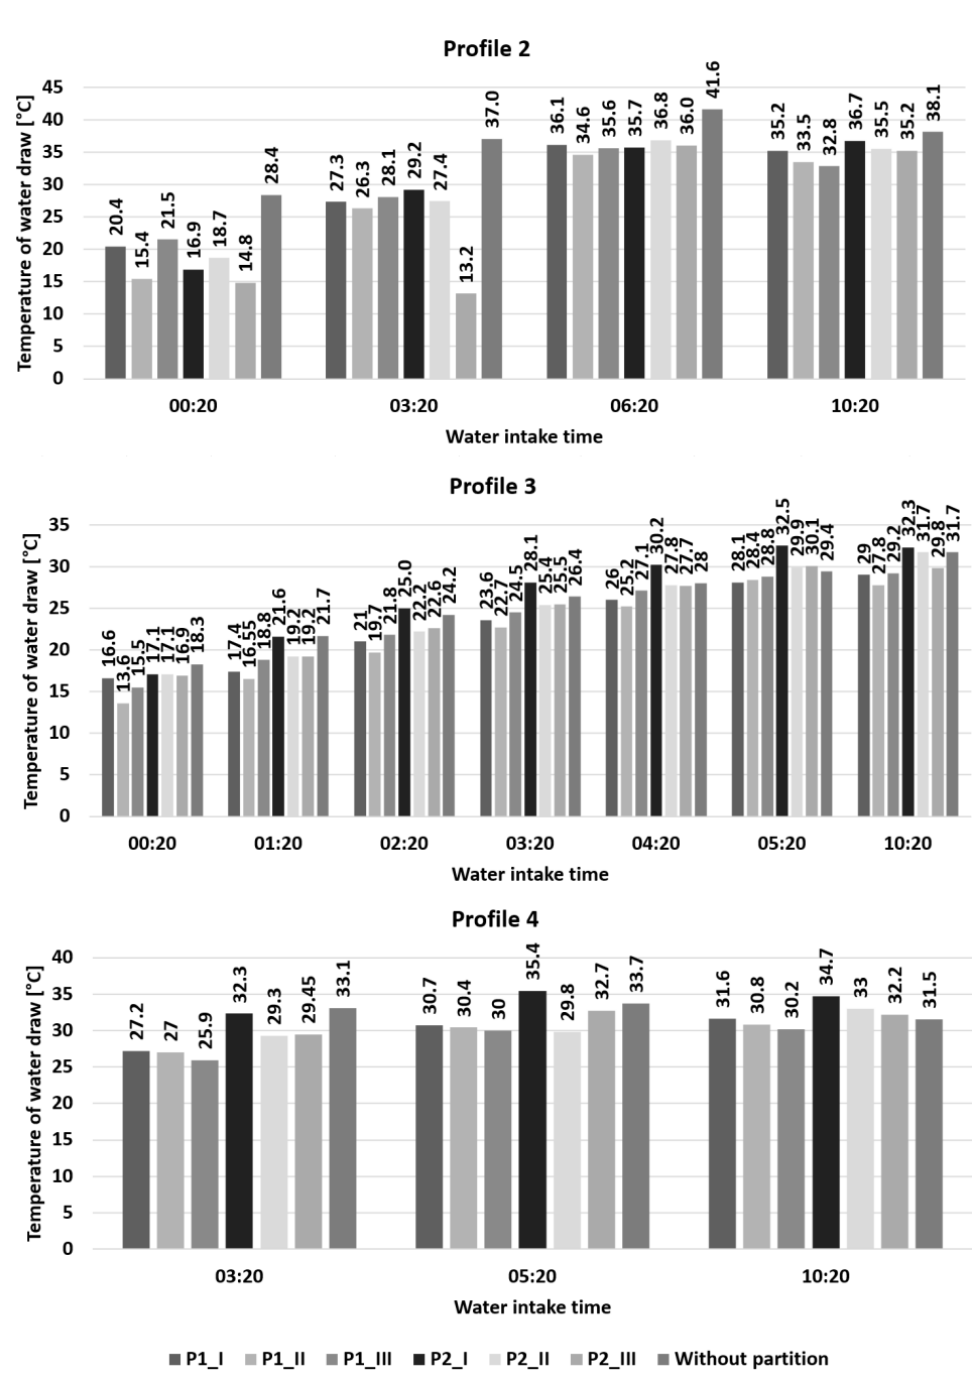
Figure 10. Temperature of the intake water from the tank ( T DHW_tank ).